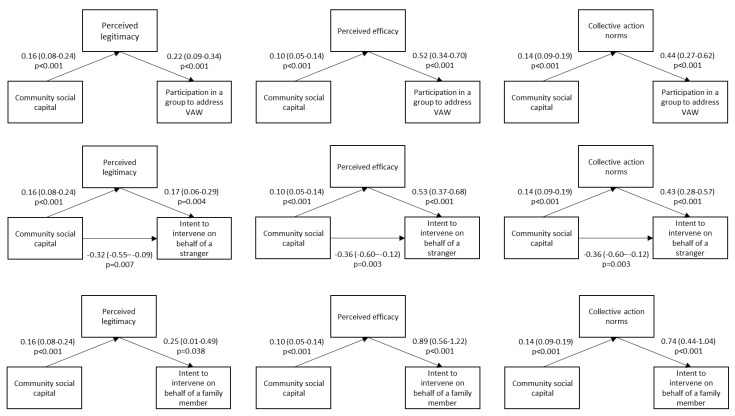
Generalised structural equation models relating social capital and psychological drivers to participation in collective action.N=2,611. Only statistically significant paths (p<0.05) are shown. Regression coefficients are reported in the format of “estimate (95% confidence interval), p-value”. Regression coefficients for paths from predictor variables to behavioural outcomes show the increase in log-odds for one standard deviation increase in the predictor. VAW, violence against women.